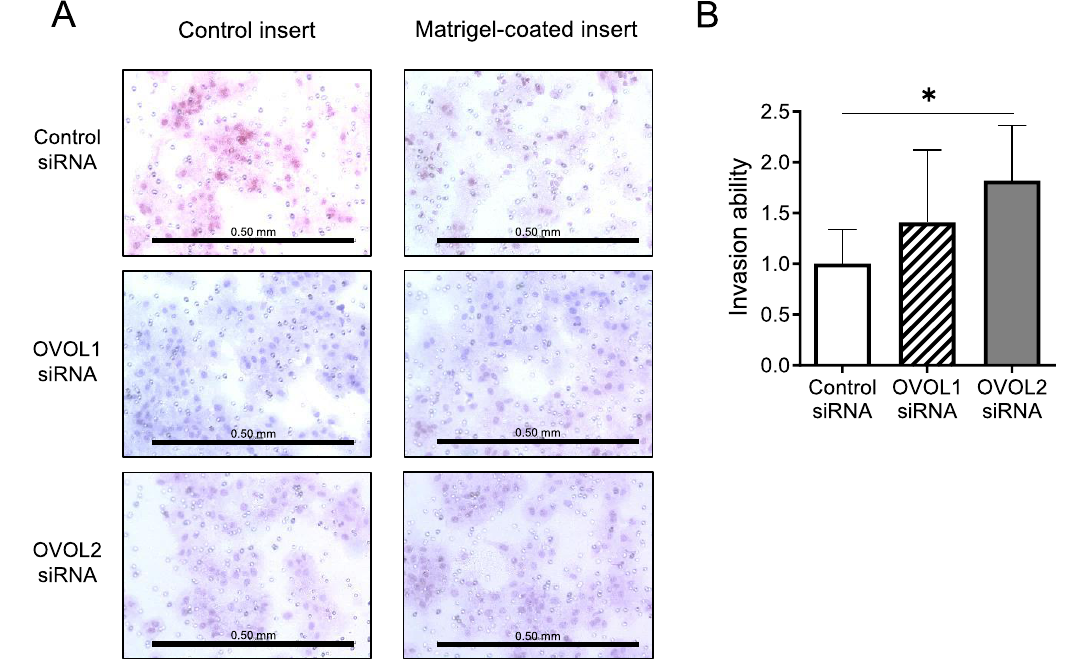
Figure 5. OVOL2 regulates invasion ability in a human SCC cell line. ( A ) Representative images, and ( B ) relative invasion ability of cells. A431 cells were transfected with control siRNA, OVOL1 siRNA, or OVOL2 siRNA and cultured in Transwell plates. Cells that translocated through control inserts or invaded Matrigel-coated inserts are stained on the membrane. Scale bar = 0.50 mm. Mann–Whitney U -test; error bars represent mean ± standard deviation. For interpretation purposes, the control siRNA value was set to 1. p -values < 0.05 were assumed to indicate a statistically significant di ff erence; * p < 0.05. Assays were conducted in triplicate and repeated at least three times in separate experiments